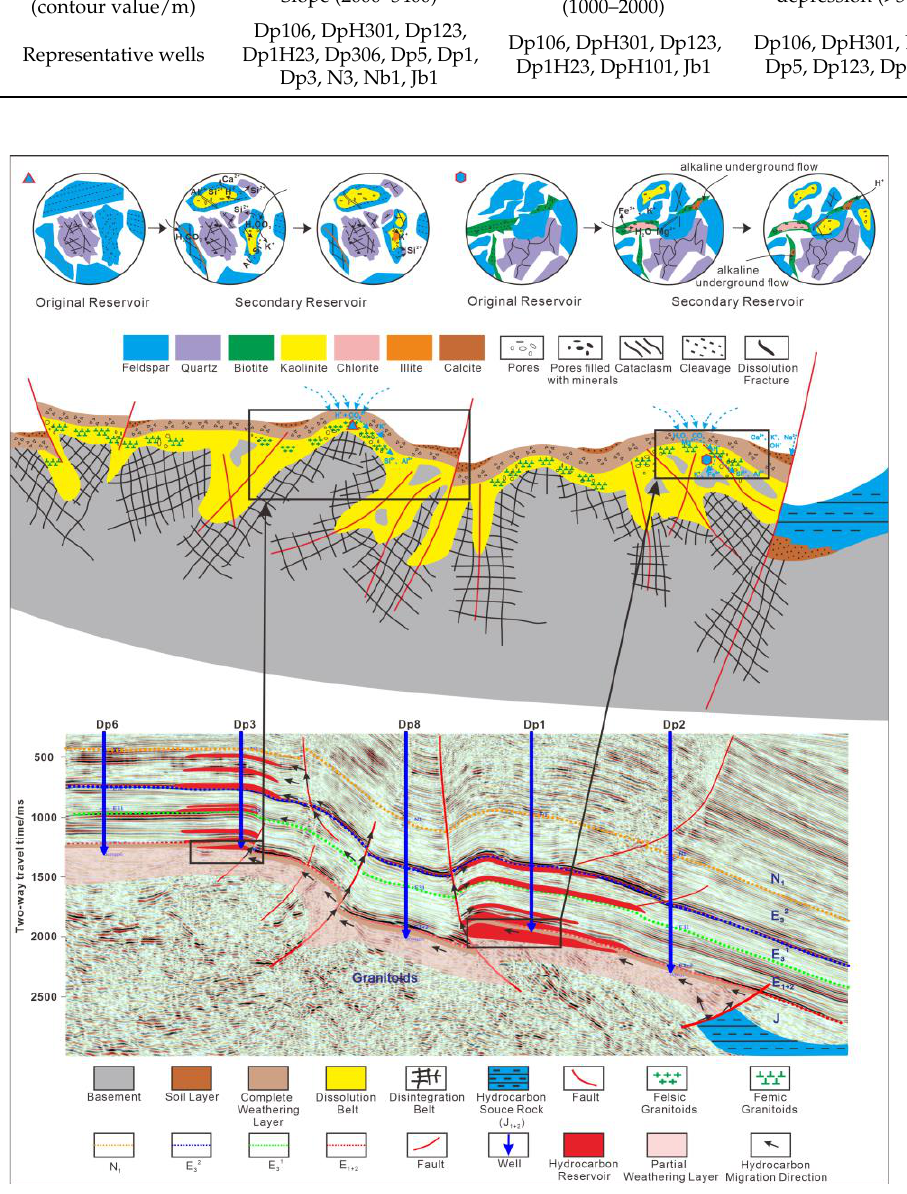
Figure 15. Mechanism model of the granitoids reservoir in Qaidam Basin (the data of the hydrocarbon reservoir were tested at the PetroChina Qinghai oilfield).